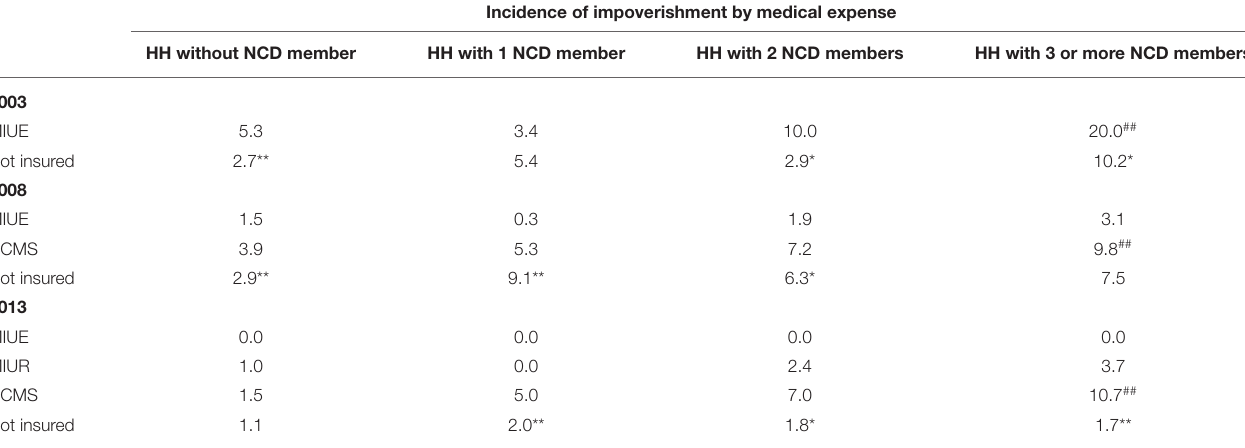
TABLE 4 | Impoverishment by medical expense distribution in households with different numbers of NCD in different medical health insurance